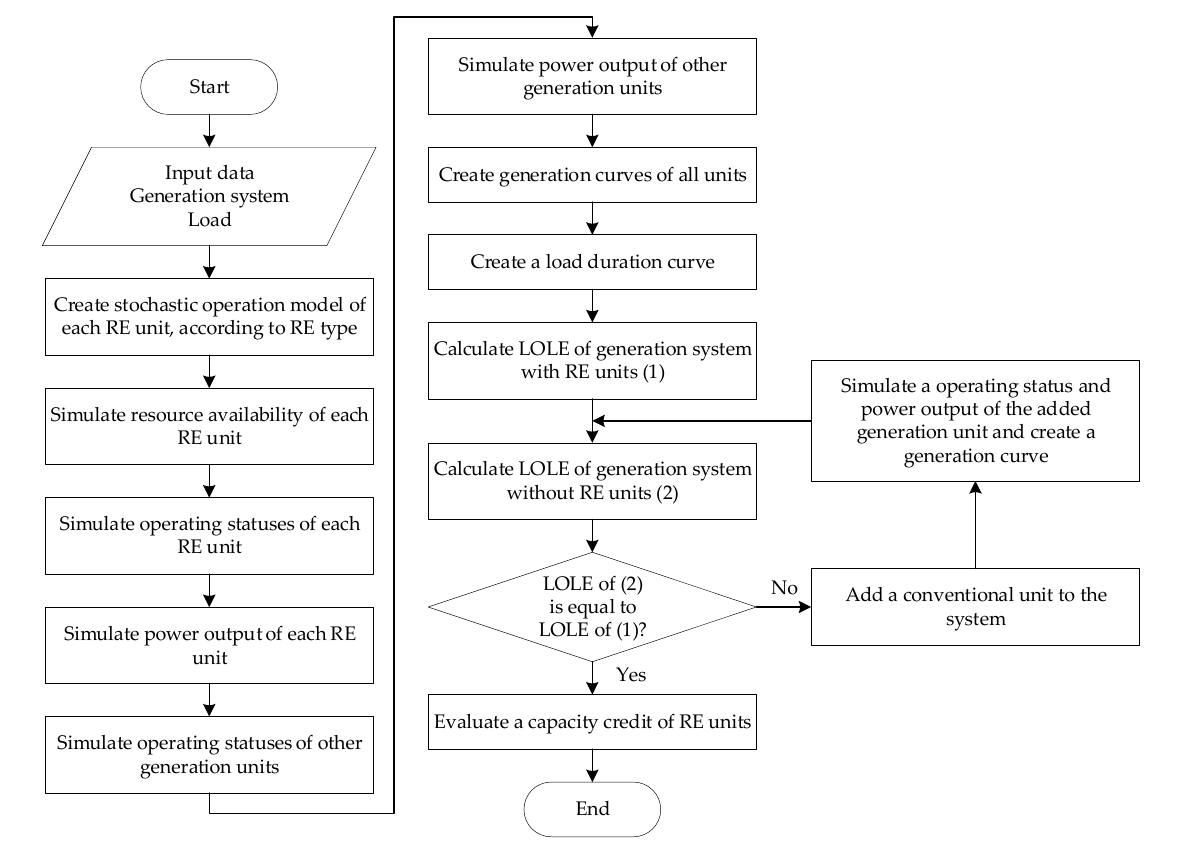
Figure 2. Procedure of capacity credit evaluation of RE power plants.